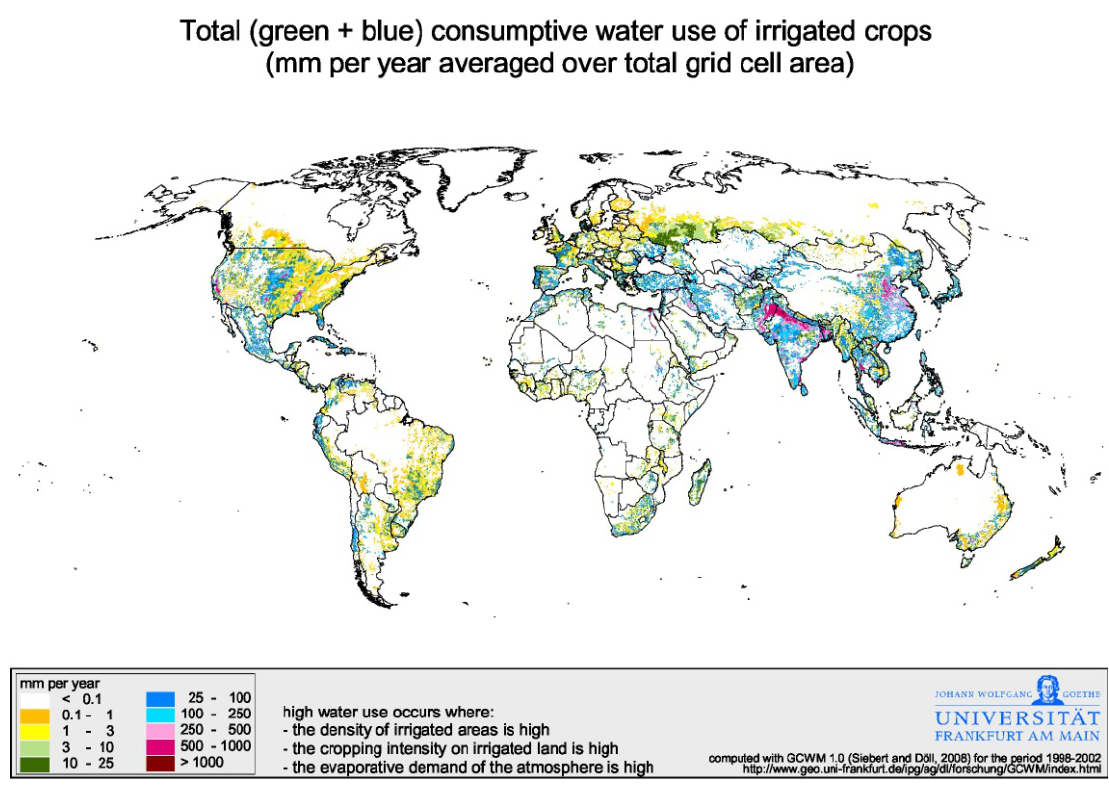
here includes green water (direct precipitation over the irrigated areas) plus additional blue water required (water from lakes, rivers, reservoirs, and ground water from aquifers) for sustaining crops. The highest water use (500 mm or more) is in the Ganges basin (India), Indus basin (Pakistan), areas near Beijing (China), and California valley (USA). High water use occurs in areas with high irrigation density, cropping intensity, and evaporative demand as noted in the figure. The irrigated areas used to compute water required are from MIRCA2000 data set (www.geo.uni-frankfurt.de/ipg/ag/dl/forschung/MIRCA/ index. html) which is derived from Siebert et al .